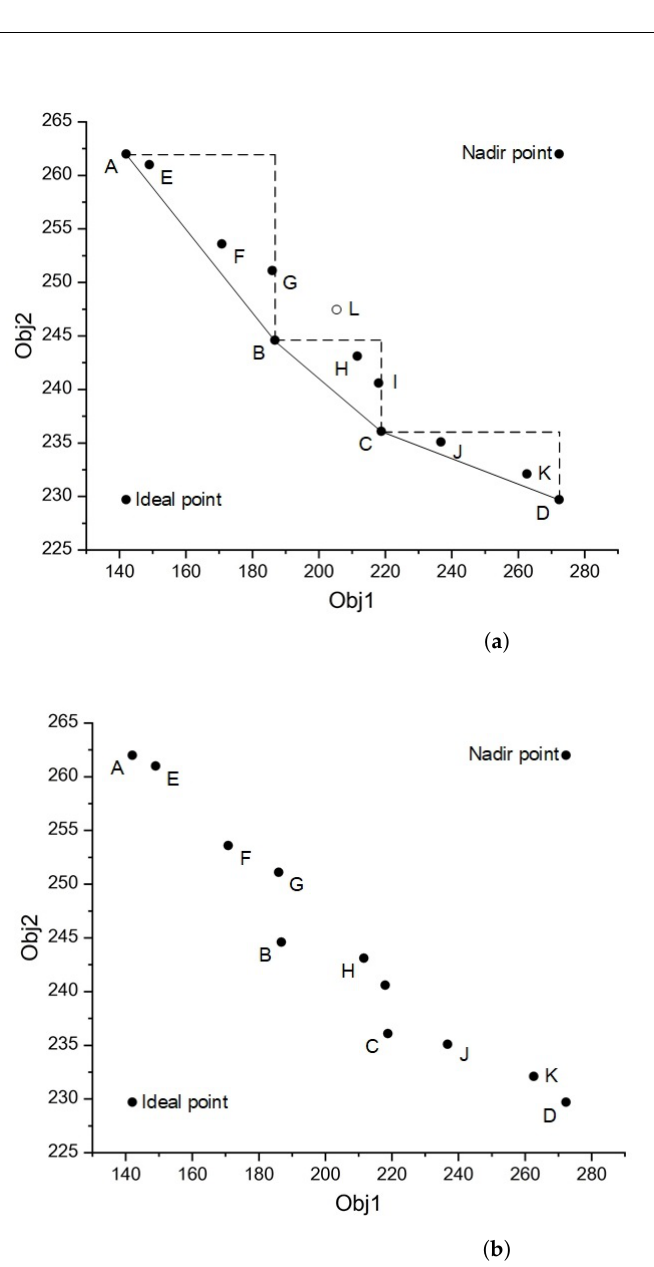
Figure 5. Optimal solution for the example instance. ( a ) Nondominated points. ( b ) Pareto-optimal